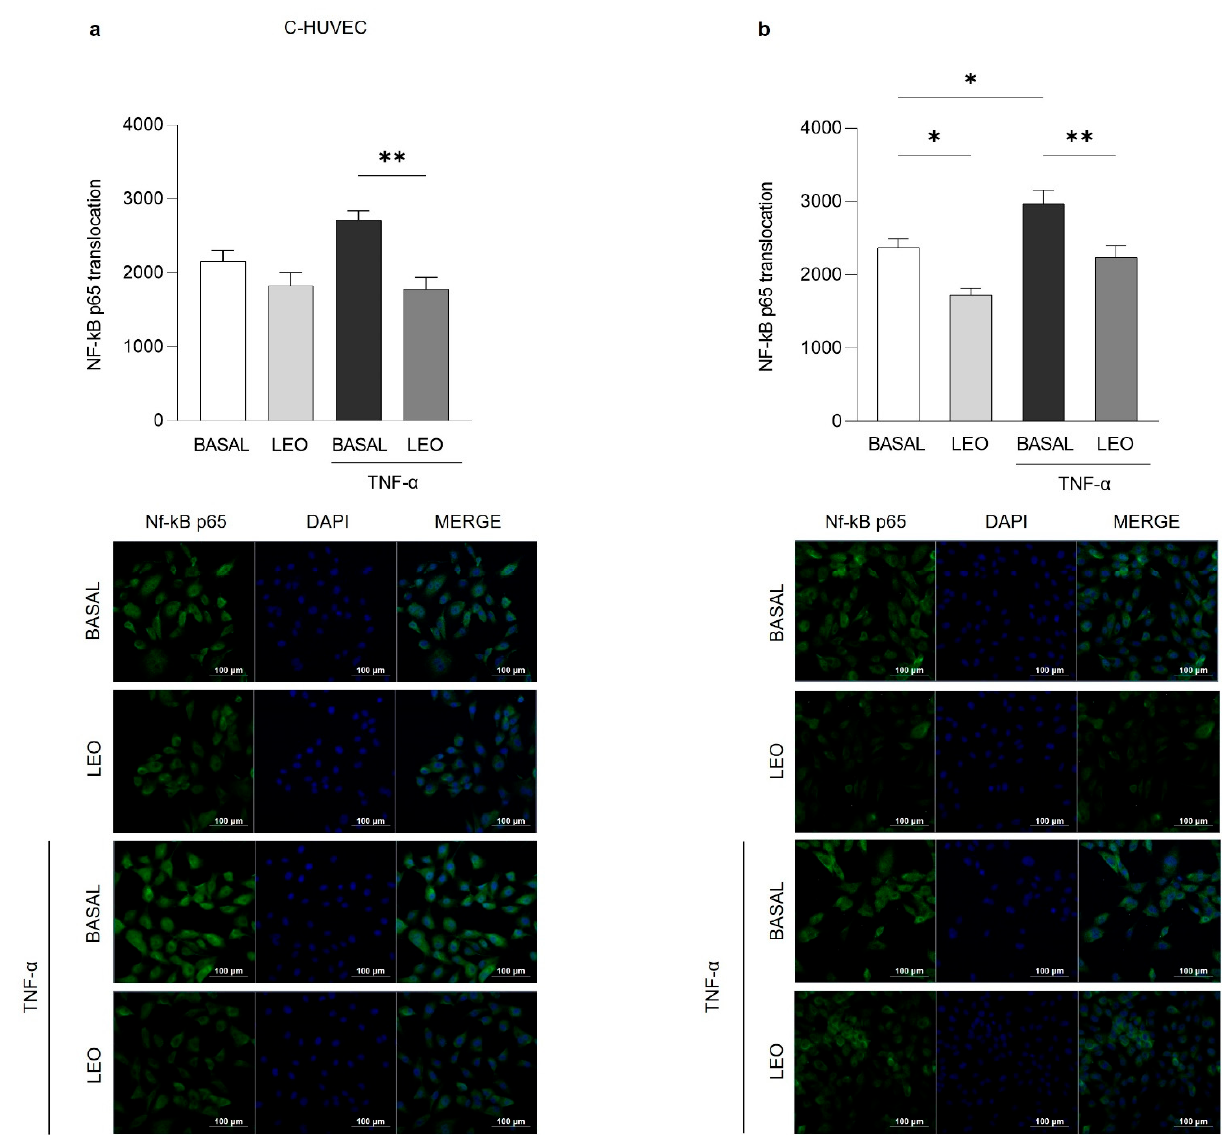
Figure 7. Effects of LEO on NF- κ B p65 nuclear translocation in C- and GDM-HUVEC. Graphs and representative immunofluorescence images show NF- κ B p65 nuclear translocation in C- and GDM- HUVEC by immunofluorescence staining. Cells have been marked with NF- κ B p65 primary antibody and Alexa Fluor 488 anti-rabbit secondary antibody, and nuclei were stained with DAPI, following 24h of treatment with LEO (0.025%). Data, calculated as the ratio of the MFI of NF- κ B p65 (green) on the MFI of nuclei (blue), were obtained by analyzing at least 3 different fields for each image with ImageJ software (NIH, ImageJ software). ( a , b ) ** p < 0.01 TNF- α vs. LEO+TNF- α ; ( b ) * p < 0.05 BASAL vs. TNF- α or LEO. Scale bar: 100 µm.